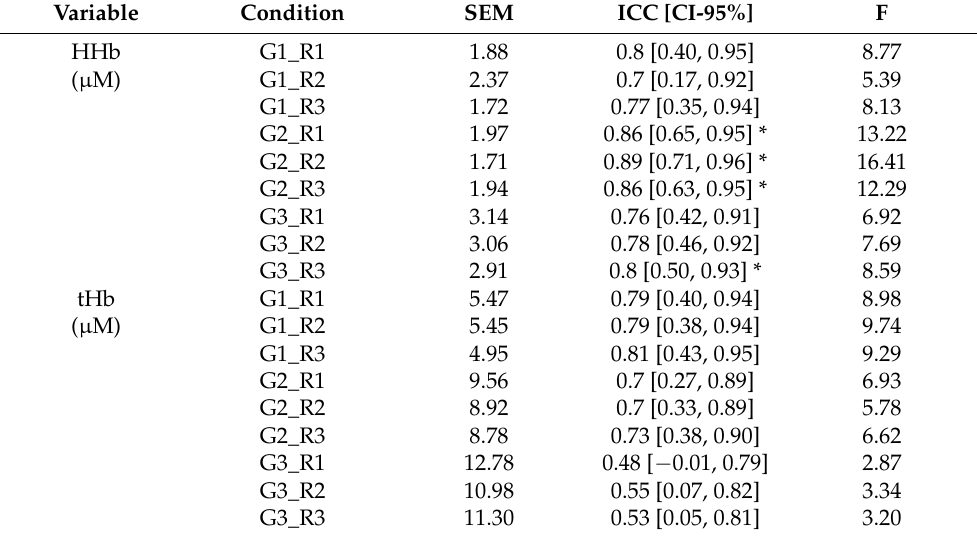
Table 10. Cont . Variable